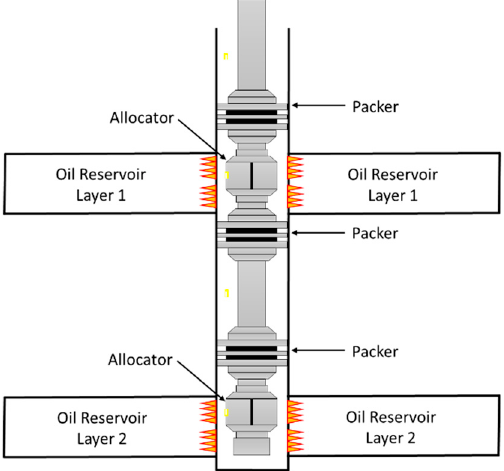
Figure 1. Schematic diagram of allocator.